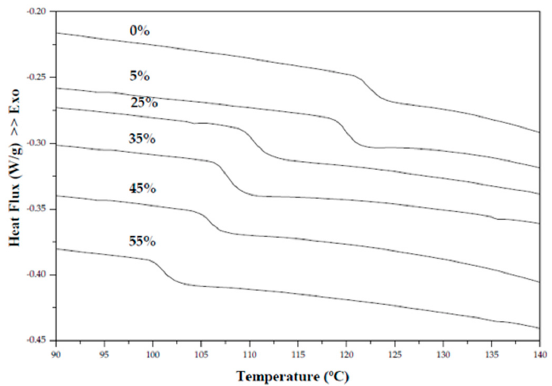
Figure 3. Differential scanning calorimetry (DSC) thermograms of edible films based on arrowroot starch and gelatin incorporated with cranberry.